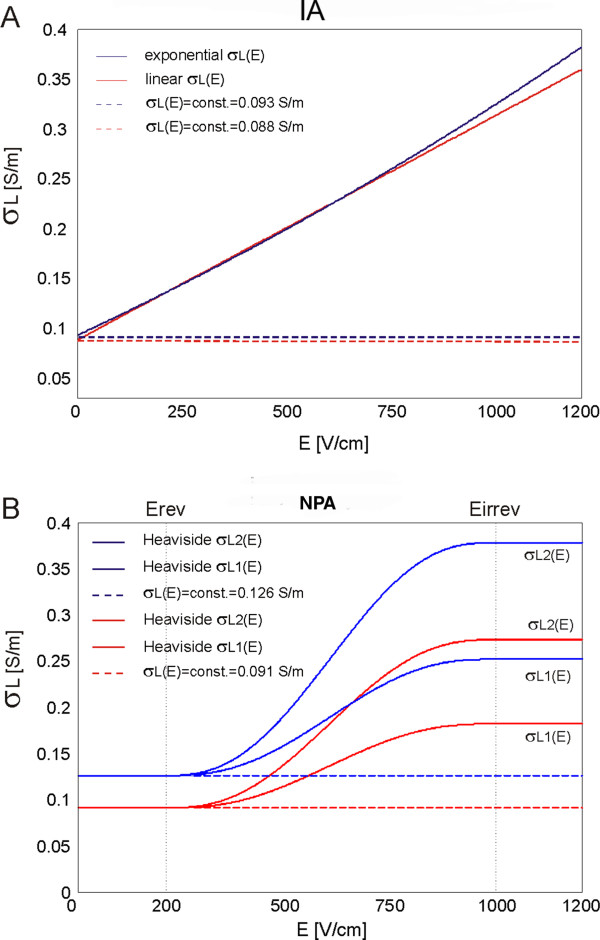
Baseline conductivities (σL(E) = σ0 = const.) and tissue conductivity vs. electric field dependencies σL(E). A. σ0 and σL(E) identified by using IA and B. σ0 and σL(E) predefined in our numerical models based on the data from literature – smoothed Heaviside σL(E) was predefined for the numerical calculations with NPA. σL1(E) and σL2(E) stand for the smoothed Heaviside relationships σL(E) with conductivity increase factor (due to electroporatoion) of two and three, respectively.